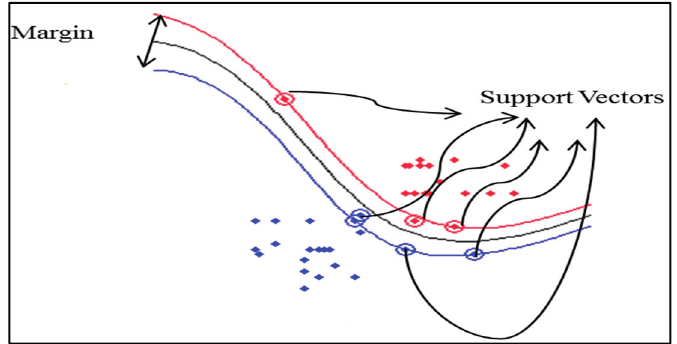
Figure 11. Diagram for SVM learning approach. The red line represents the first class, black line represents the margin, and the blue line represents the second